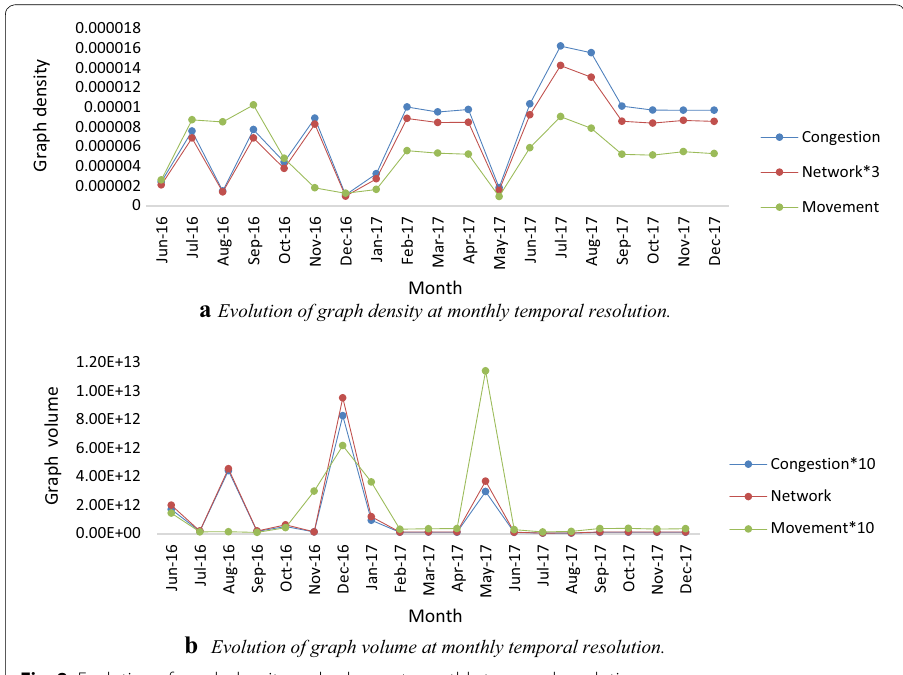
Fig. 8 Evolution of graph density and volume at monthly temporal